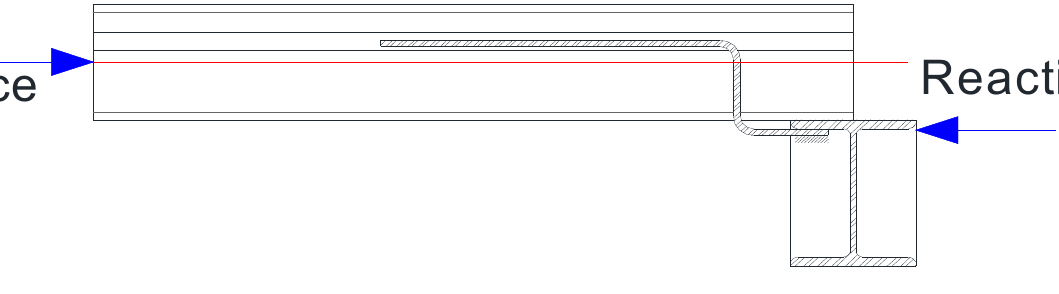
Figure 2. Eccentricity of the load application in relation to the reaction.